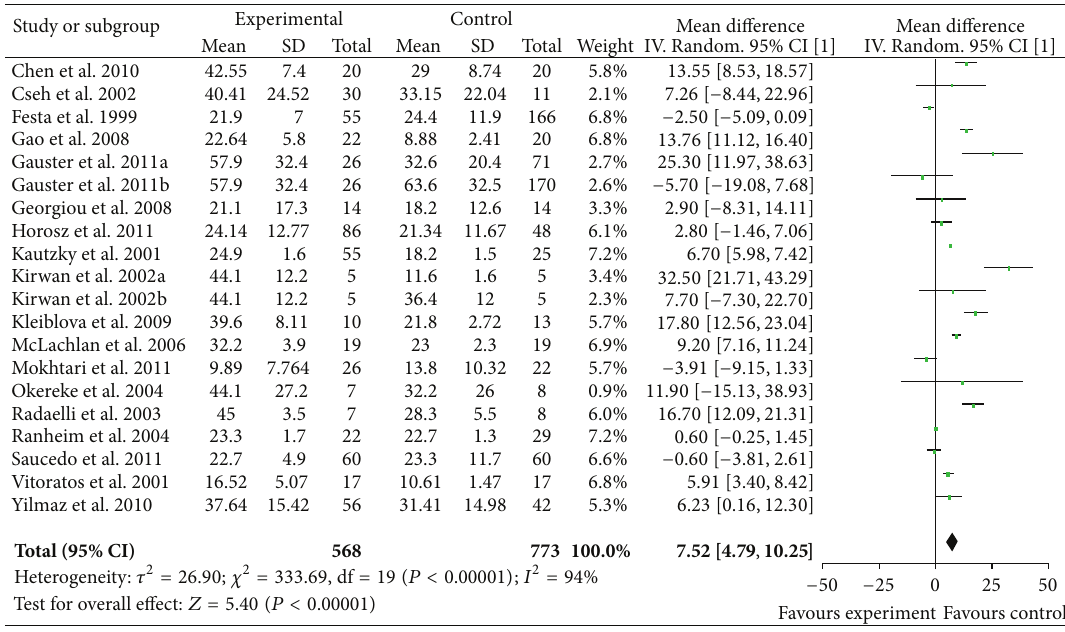
Figure 3: Mean difference (MD) and 95% CI of individual studies and pooled data for the association of maternal concentration of leptin with GDM risk. Positive values denote higher in GDM patients; negative values denote higher in healthy control